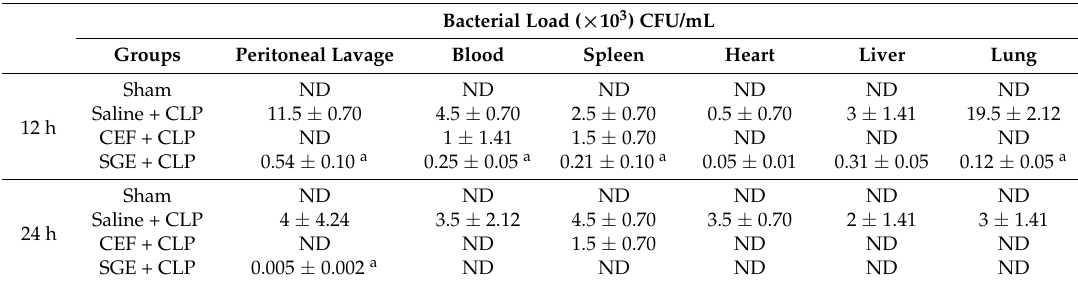
Table 1. Bacterial load in peritoneal lavage, blood and other tissues of septic mice pretreated with SGE (35 μ g/kg), CEF (20 mg/kg), or saline.